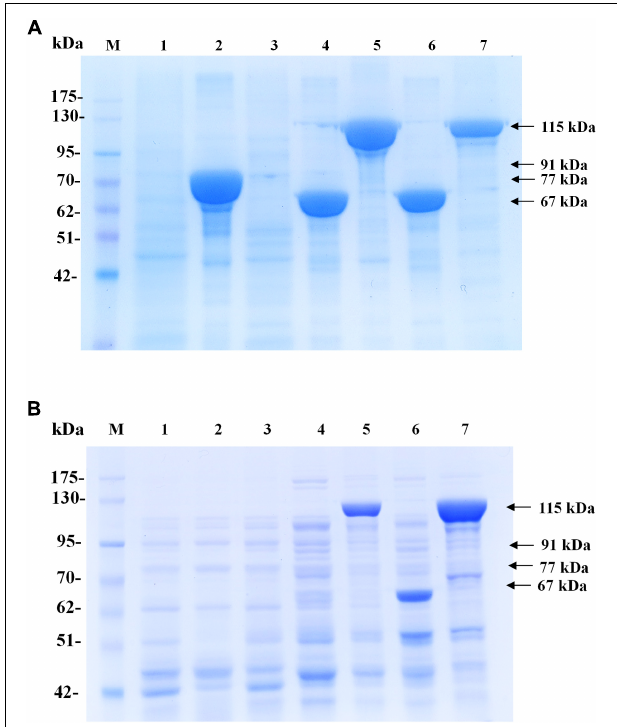
FIGURE 3 | Time courses of PHB production (g/L). (A) The insoluble PhaC A - 04 protein was confirmed by SDS-PAGE analysis (20 µ g of total protein was loaded in each lane). (B) The soluble PhaC A - 04 protein was confirmed by SDS-PAGE analysis (20 µ g of total protein was loaded in each lane). Lane M, Protein molecular weight marker; lane 1, E. coli JM109 (pUC19-nativeP- phaCAB A - 04 ) under short induction temperature profile, but without addition of IPTG; lane 2, E. coli JM109 pBAD/Thio-TOPO- phaCAB A - 04 under short induction method; lane 3, E. coli JM109 (pGEX-6P-1- phaCAB A - 04 ) under short induction method; lane 4, E. coli JM109 (pColdI- phaCAB A - 04 ) under short induction method; lane 5, E. coli JM109 (pColdTF- phaCAB A - 04 ) under short induction method; lane 6, E. coli JM109 (pColdI- phaCAB A - 04 ) under conventional induction method; lane 7, E. coli JM109 (pColdTF- phaCAB A - 04 ) under conventional induction method. The band appearing in the SDS-PAGE at the position corresponding to that of the phaC A - 04 protein was 64 kDa in size for pUC19-nativeP- phaCAB A - 04 , His-tagged phaC A - 04 fusion protein was 67 kDa in size for pColdI- phaCAB A - 04 , thioredoxin-tagged phaC A - 04 fusion protein was 77 kDa in size for pBAD/Thio-TOPO- phaCAB A - 04 , GST-tagged phaC A - 04 fusion protein was 91 kDa in size for pGEX-6P-1- phaCAB A - 04 , and the fusion